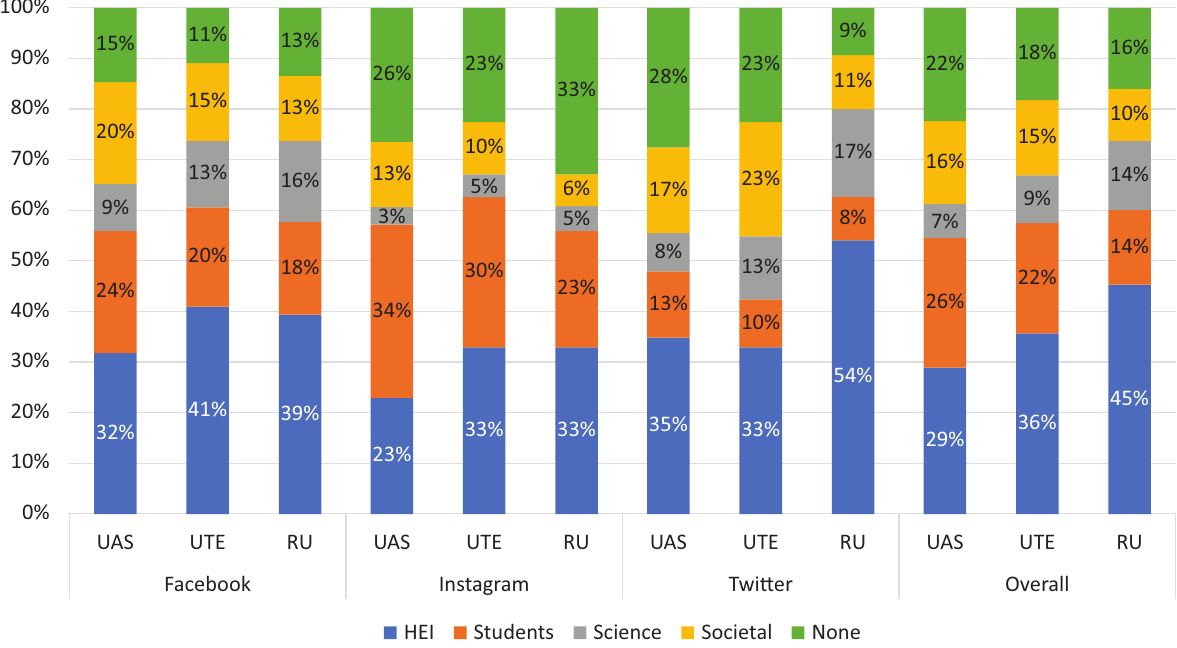
Figure 5. Percentage of total stakeholders mentioned in social media content published by Swiss HEIs on Facebook, Instagram, and Twitter ( n = 4,500). Notes: Stakeholders coded as “HEI” = individuals or groups who were academic employ‐ ees or administrative staff; “Students’’ = prospective, current, or former students of the university; “Science’’ = individuals or organizations that were not “HEIs” themselves but were active in academia, e.g., visiting professors; “Societal” = actors and organizations from politics, media, the arts, culture, and industry; “None” was coded if no identifiable stakeholder was included in the post. UAS = universities of applied sciences; UTE = universities of teacher education; RU =